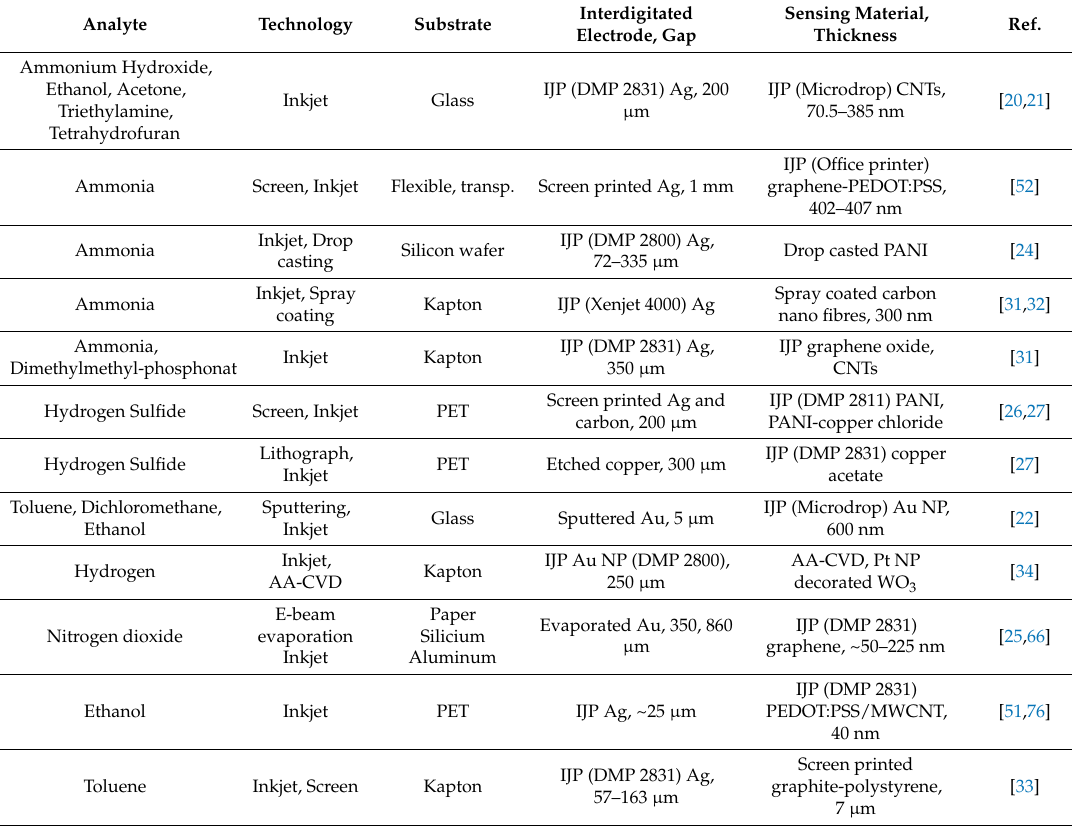
Table 1. Selection of research works reporting on inkjet-printed chemiresistive